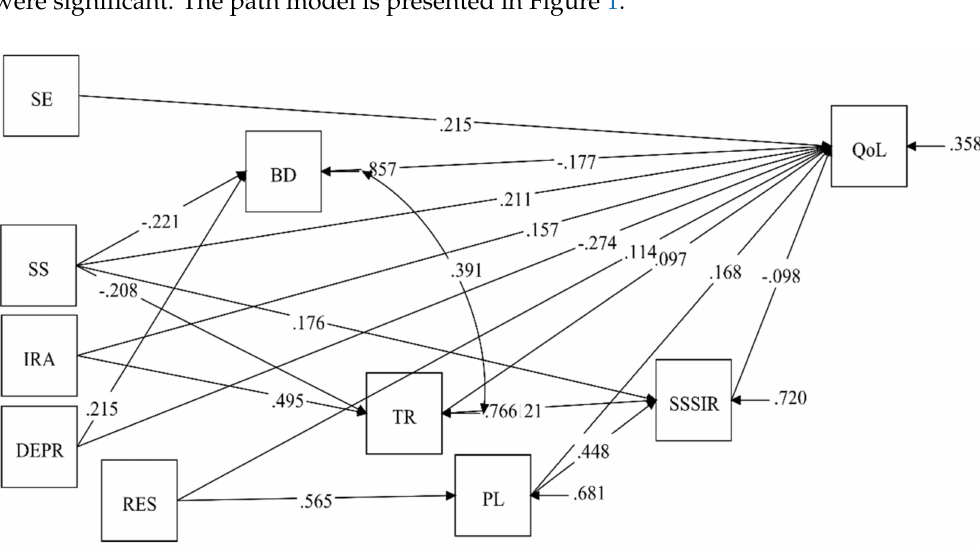
Figure 1. Path model. SE—self-efficacy; SS—social support; IRA—intensity of religious attitude; DEPR—TPI depression; RES—resilience; BD—behavioral disengagement; TR—turning to religion; PL—planning; SSSIR—seeking social support for instrumental reasons; QoL—quality of